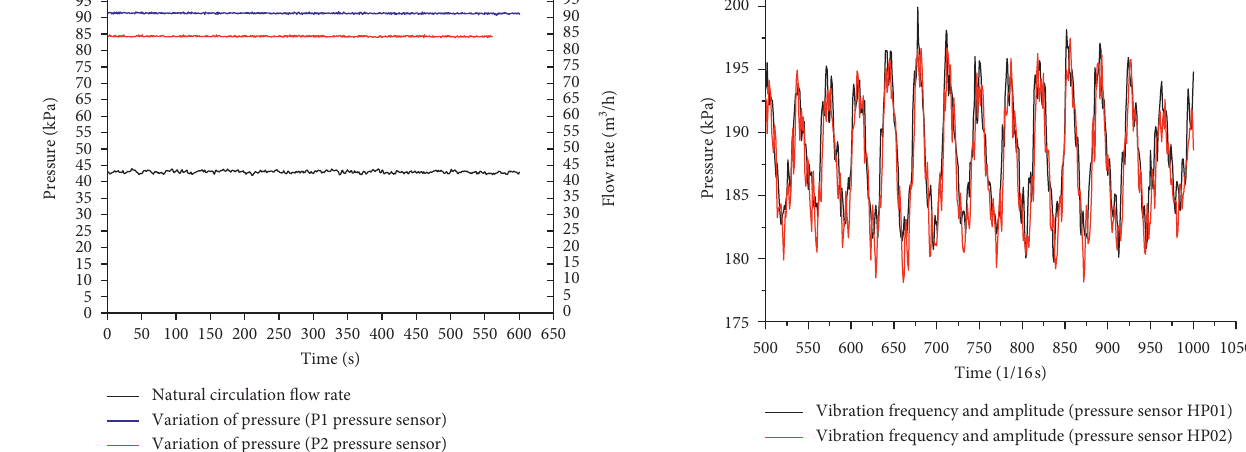
Figure 12: Fluctuation pressure is stable with water level of 8m.